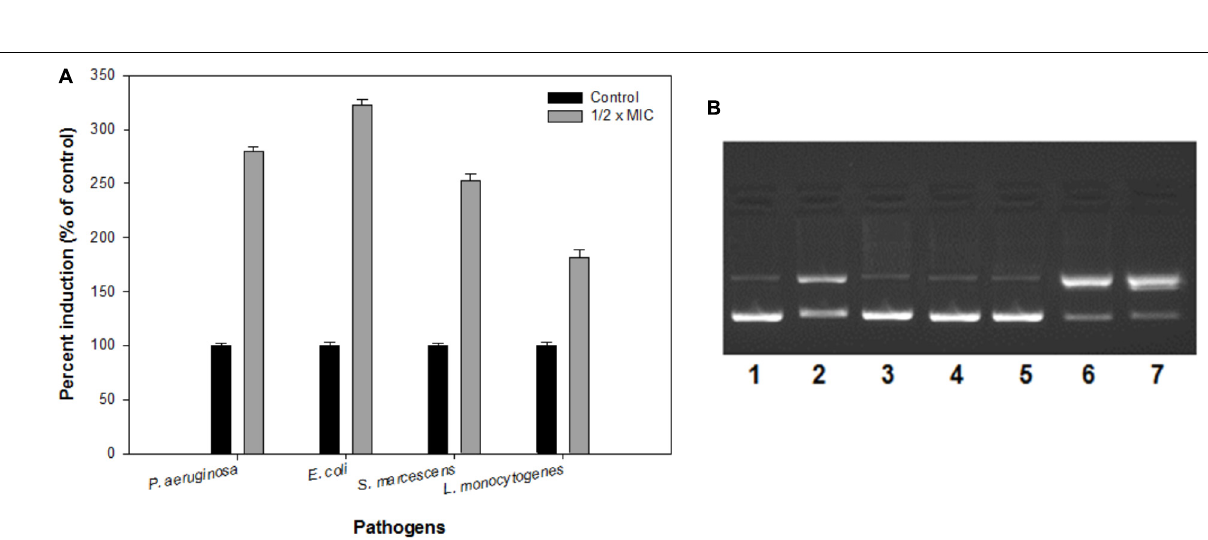
FIGURE 6 | SEM images of L. monocytogenes cells treated with IONPs and their EDX spectra.